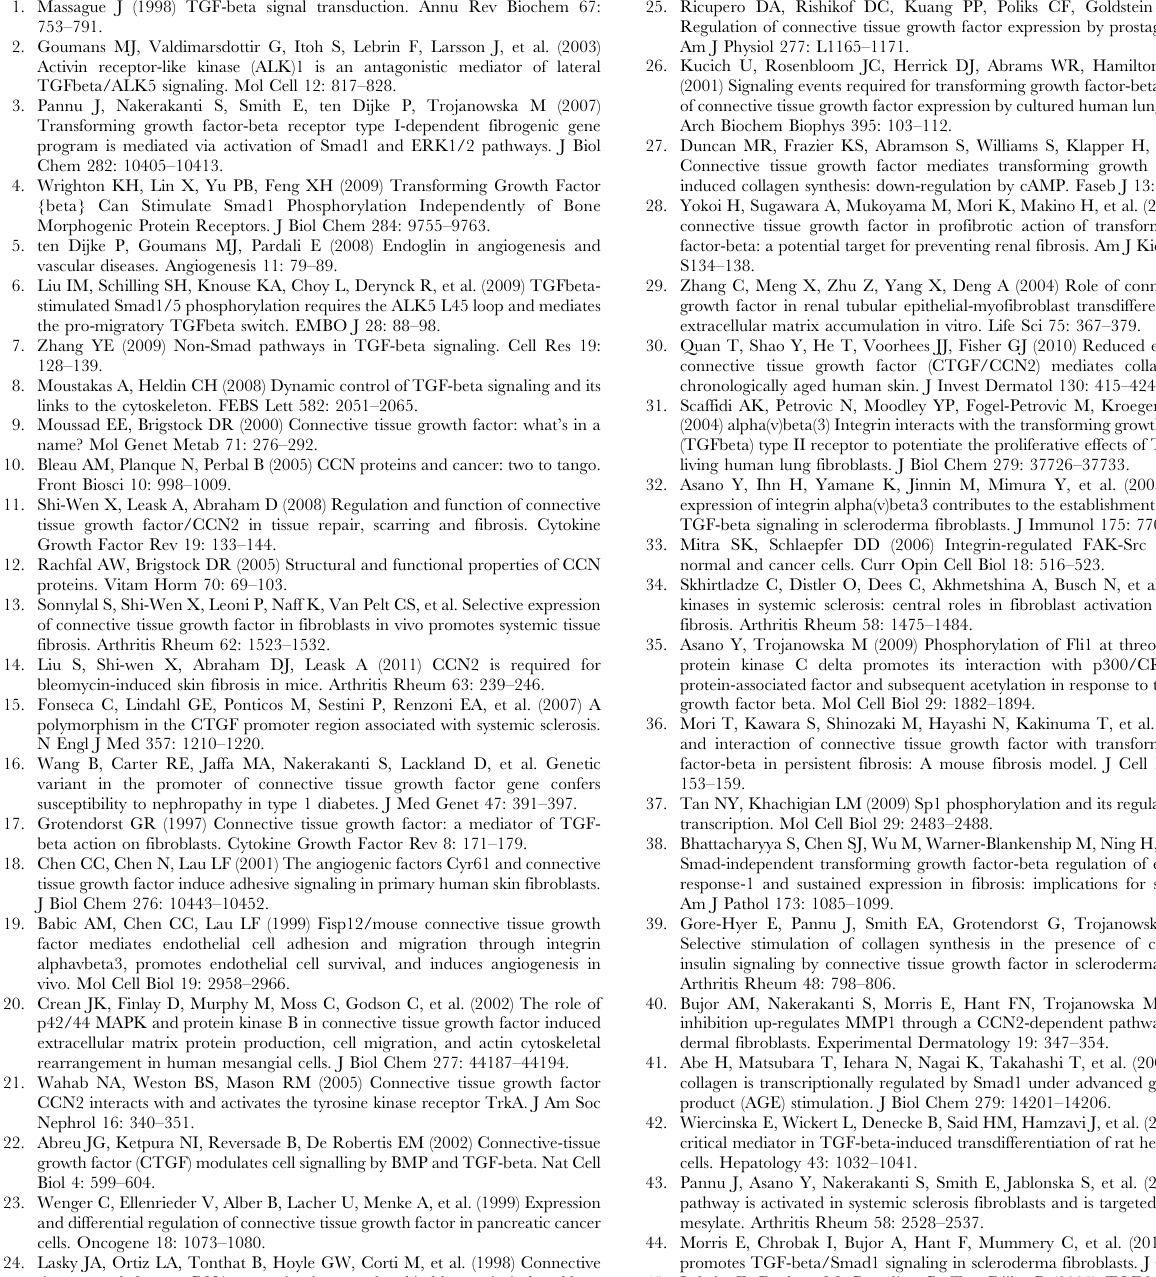
Figure S4 Graphical presentation of densitometric scans of Smad1 protein levels after CCN2 stimulation as shown in Figure 5D. The values represent mean 6 S.E. (n= 3, * p , 0.05)